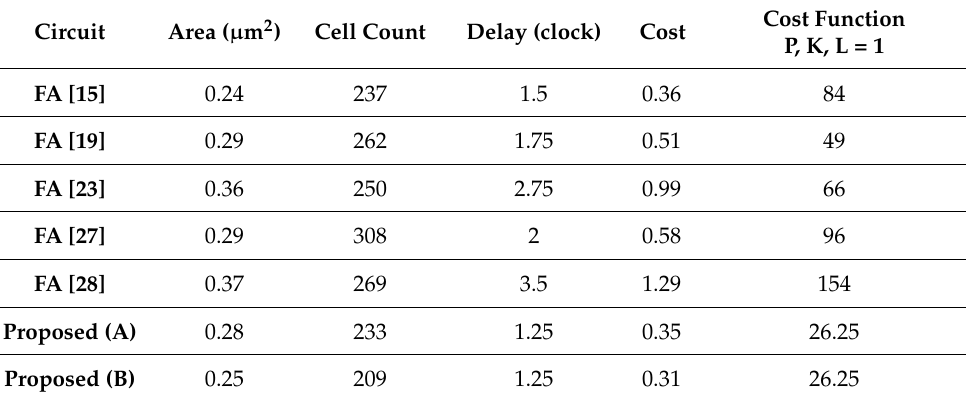
Table 3. Comparison analysis of the novel proposed 4-bit RCA circuits comparison with